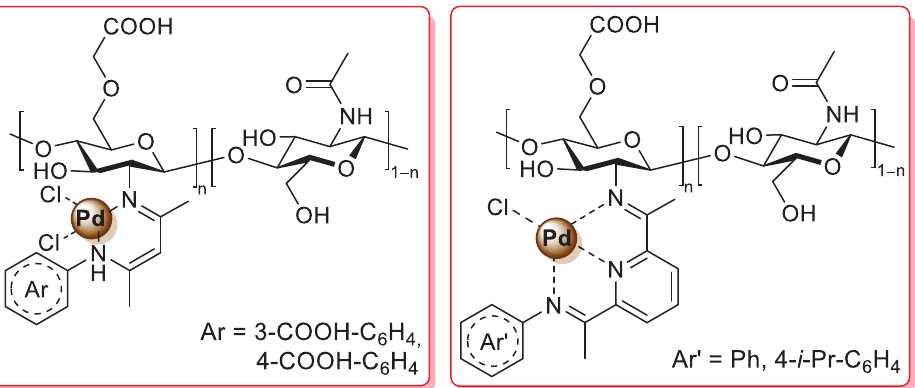
Figure 7. Chemical structure of four O -carboxymethyl chitosan-Schiff base-Pd(II) supported catalysts, developed in 2015 and 2016 by Mentes et al. [106-107].